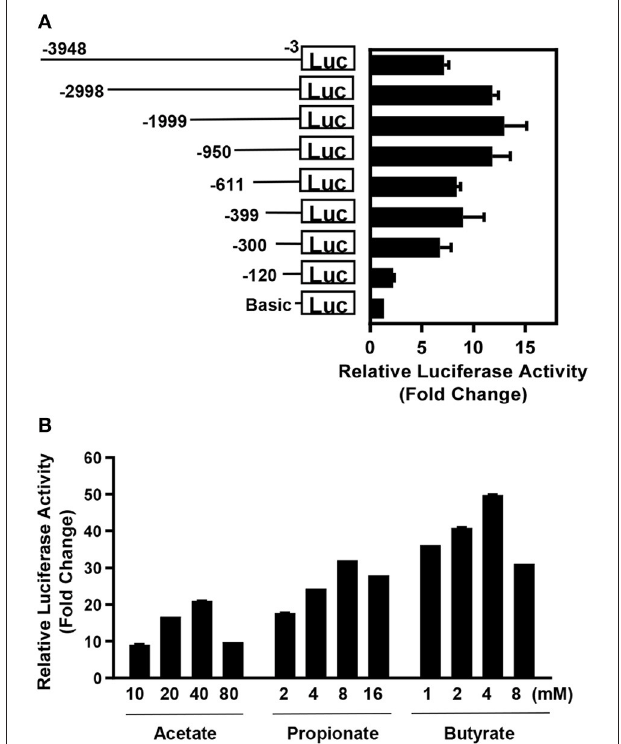
FIGURE 1 | Promoter analysis of the AvBD9 gene. (A) AvBD9 gene promoter constructs of different lengths were cloned into pGL4.21[ luc2P /Puro] luciferase reporter vector and transfected into chicken HTC macrophage cells, followed by stimulation with 8mM sodium butyrate for 24h. The fold change in luciferase activity of the cells transfected with each AvBD9 promoter construct in response to butyrate relative to that of the cells transfected with the promoterless basic vector is shown. (B) Chicken HTC cells were transfected with the pGL4.21[ luc2P /Puro] luciferase reporter vector driven by a 2-Kb AvBD9 gene promoter construct, followed by stimulation with or without different concentrations of short-chain fatty acids for 24h. For each short-chain fatty acid, fold change in luciferase activity of stimulated cells was calculated relative to that of the non-stimulation control. The results are means ± SEM of 2–3 independent